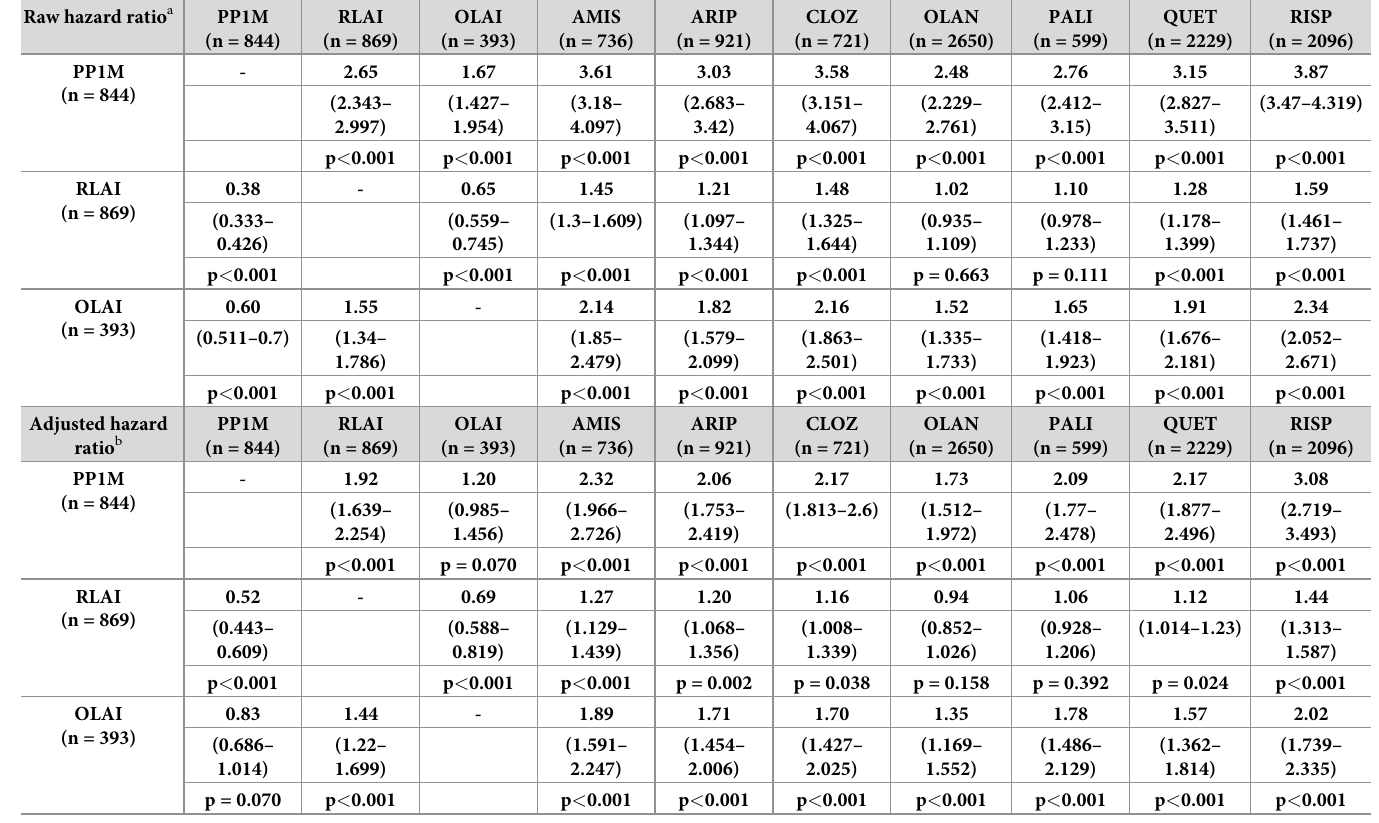
Table 4. Raw (unadjusted) and propensity score-adjusted pairwise comparisons of LAIs and oral treatments. Raw hazard ratio